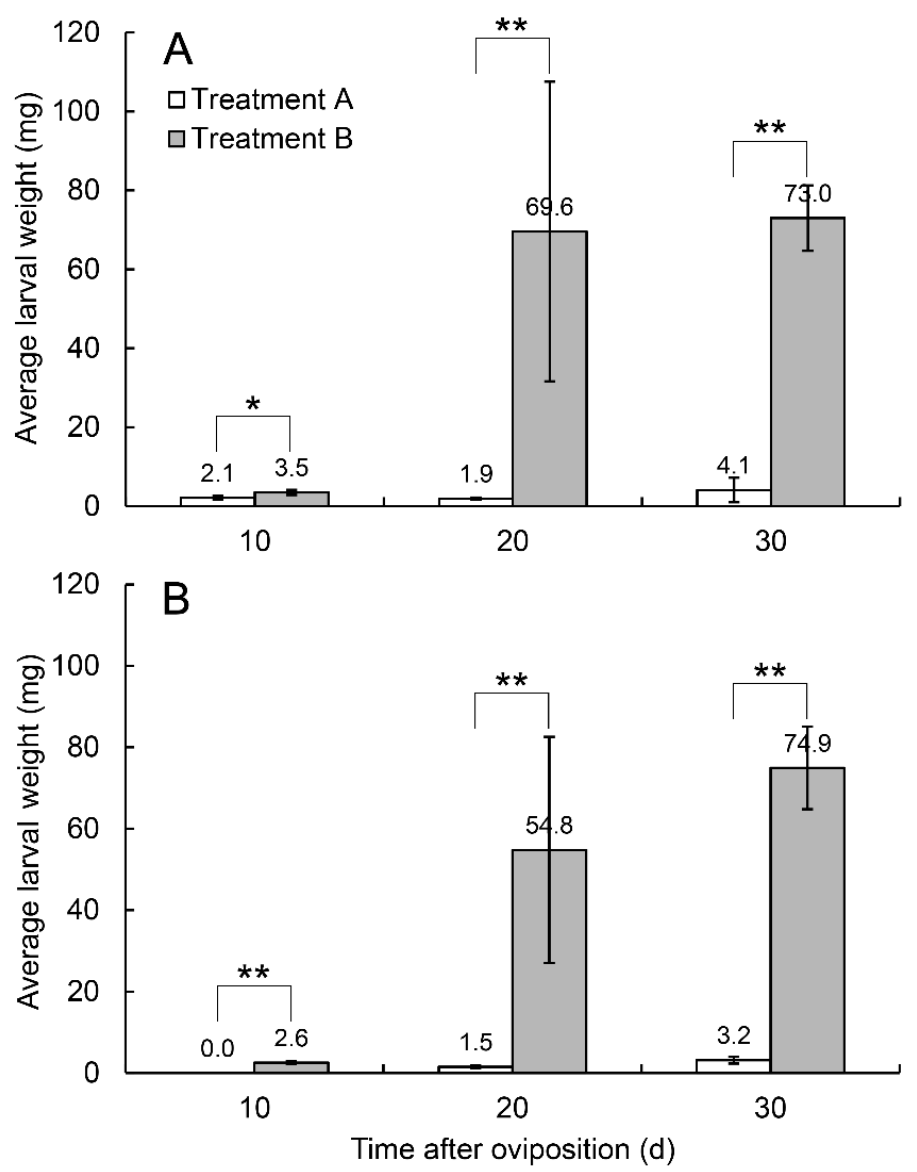
Figure 5. Average weights of larvae of R. foveipennis on days 10, 20, and 30 after oviposition under treatments A and B in 2013 ( A ) and 2018 ( B ). Vertical bars are standard deviations; * statistical significance at 0.05 level, ** statistical significance at 0.01 level.